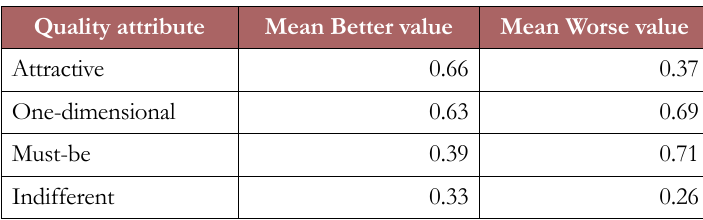
Table 3. Average values of Better / Worse indexes for the four reference quality